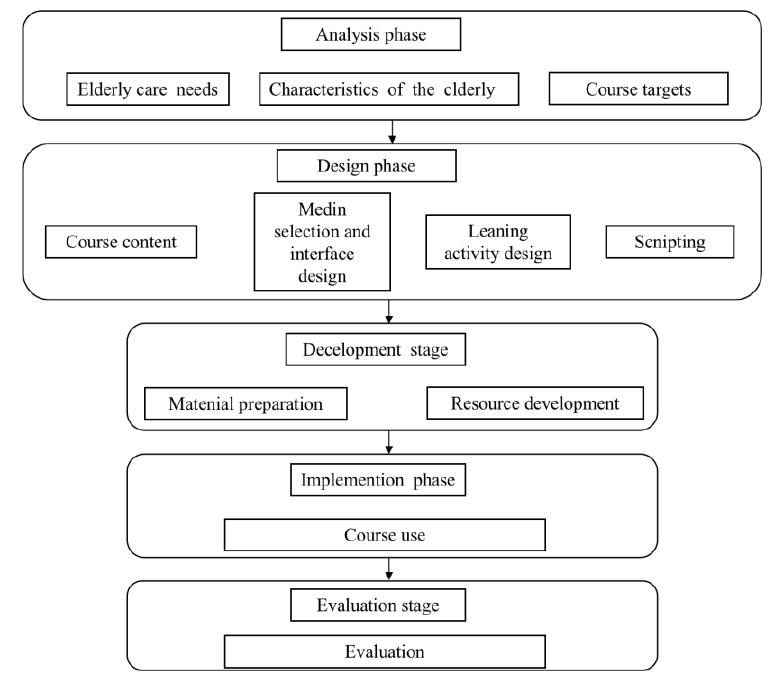
Figure 3. Interaction book design for the needs of senior education services.